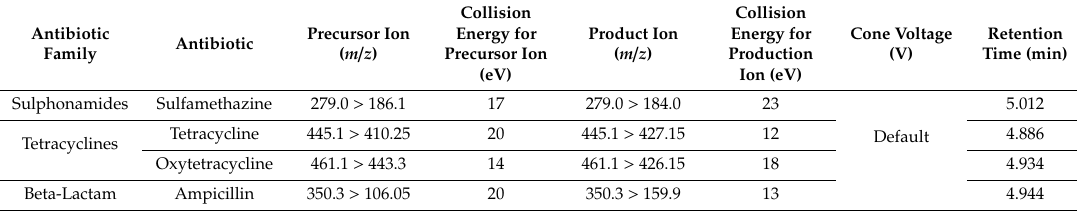
Table 1. Multiple reactions monitoring (MRM) acquisition condition for each antibiotic